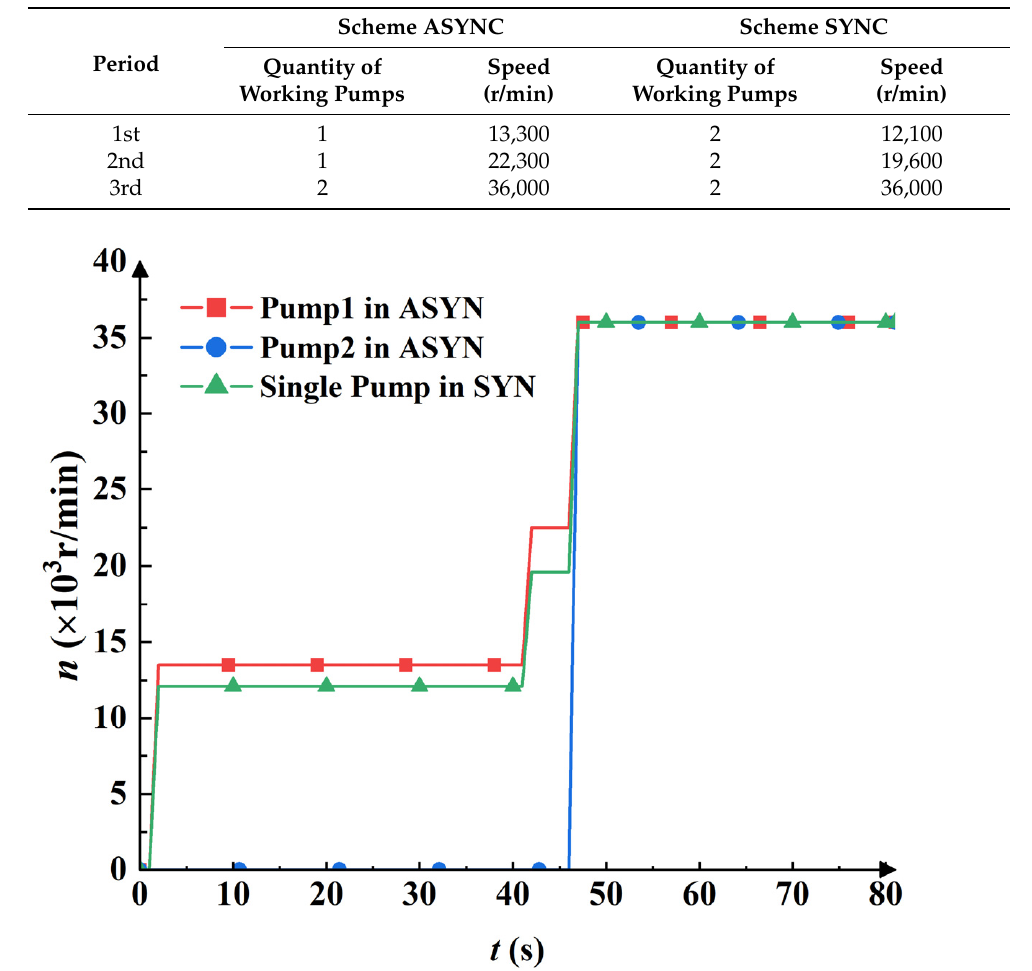
Figure 8. Pump speed comparison in Scheme ASYNC vs. Scheme SYNC.